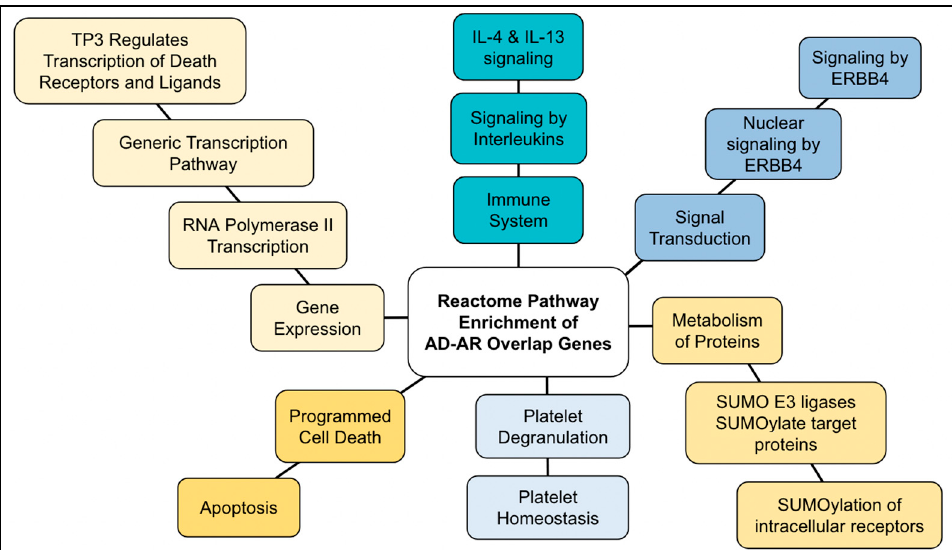
Figure 11. Diagram of the Reactome pathway enrichment of AD–AR overlap genes. The results shown in Table 5 are summarized. shown in Table 5 are